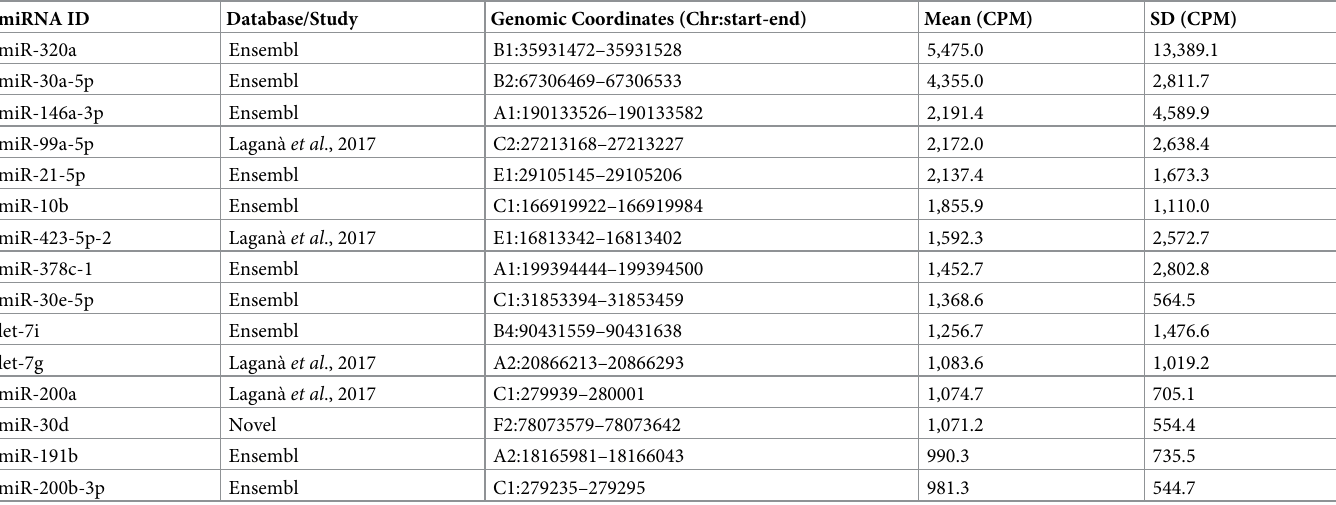
Table 2. List of the 15 most expressed miRNAs in feline urine using small